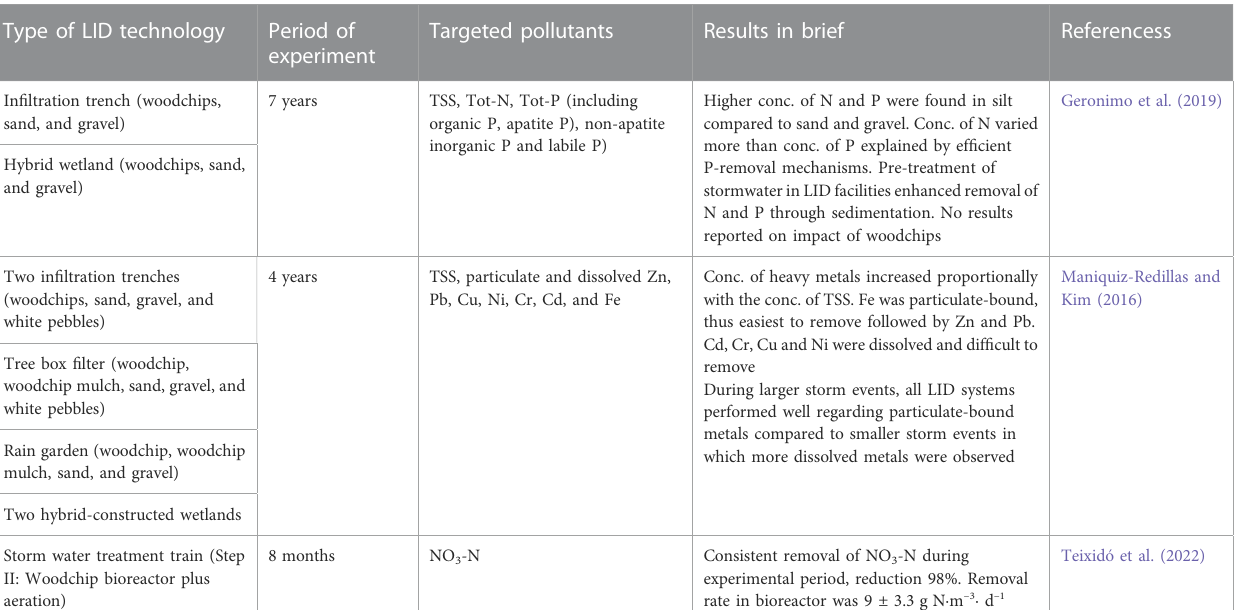
TABLE 6 Low Impact Development facilities including woodchip as fi lter